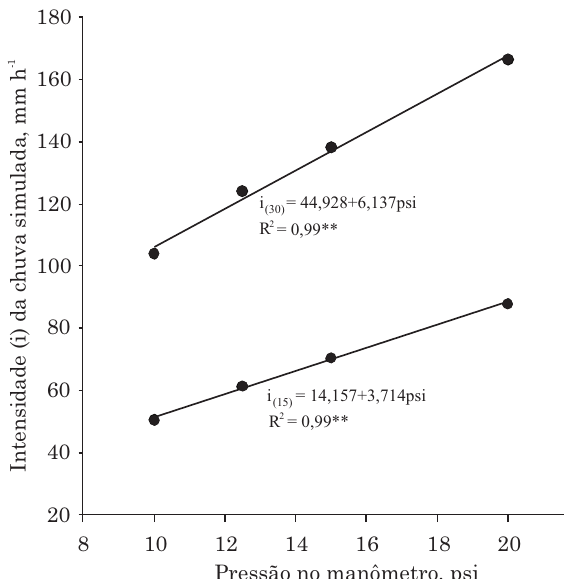
Figura 3. Relação entre a intensidade da chuva simulada com 15 registros abertos (i 15 ) e com 30 registros abertos (i 30 ) e a pressão da água observada no manômetro (psi) situado em um dos braços a 50 cm de distância da